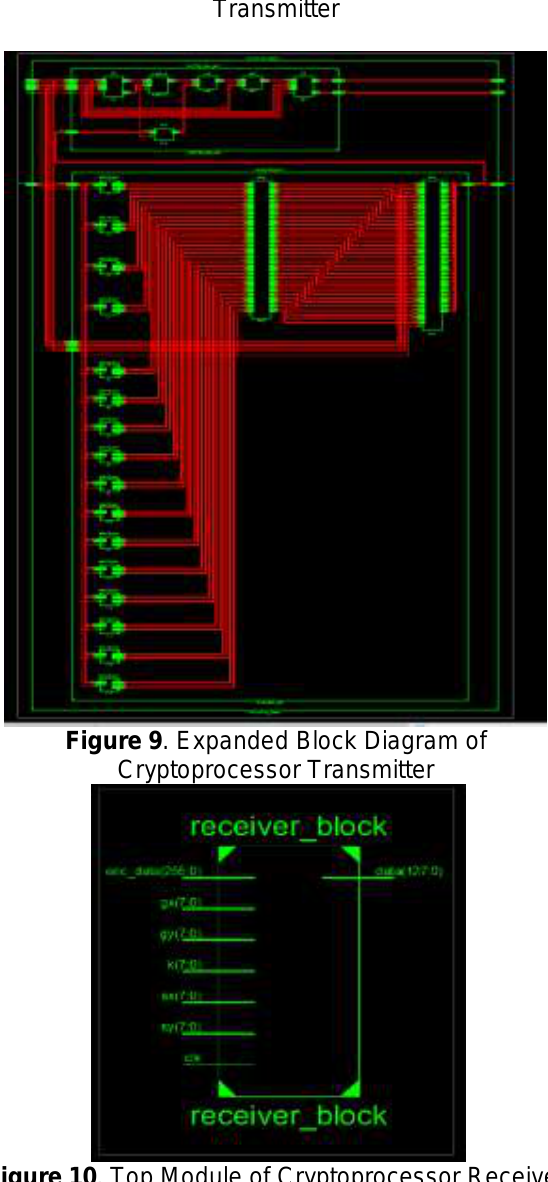
Figure 10 . Top Module of Cryptoprocessor